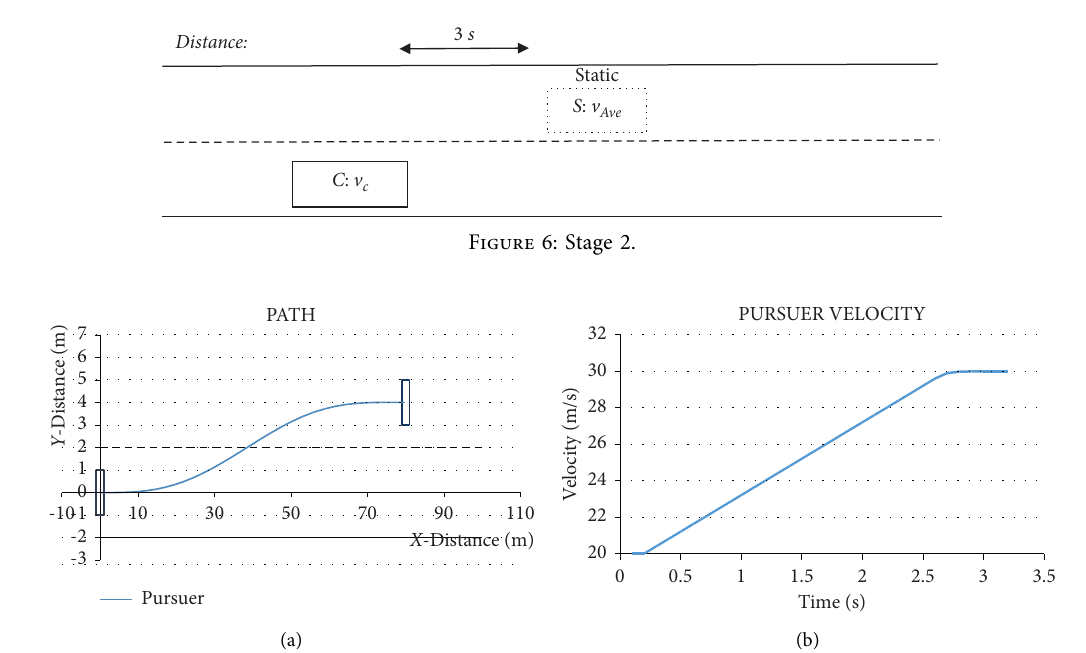
Figure 7: Joining highway without obstacle vehicle (plots for path and velocity of C ).